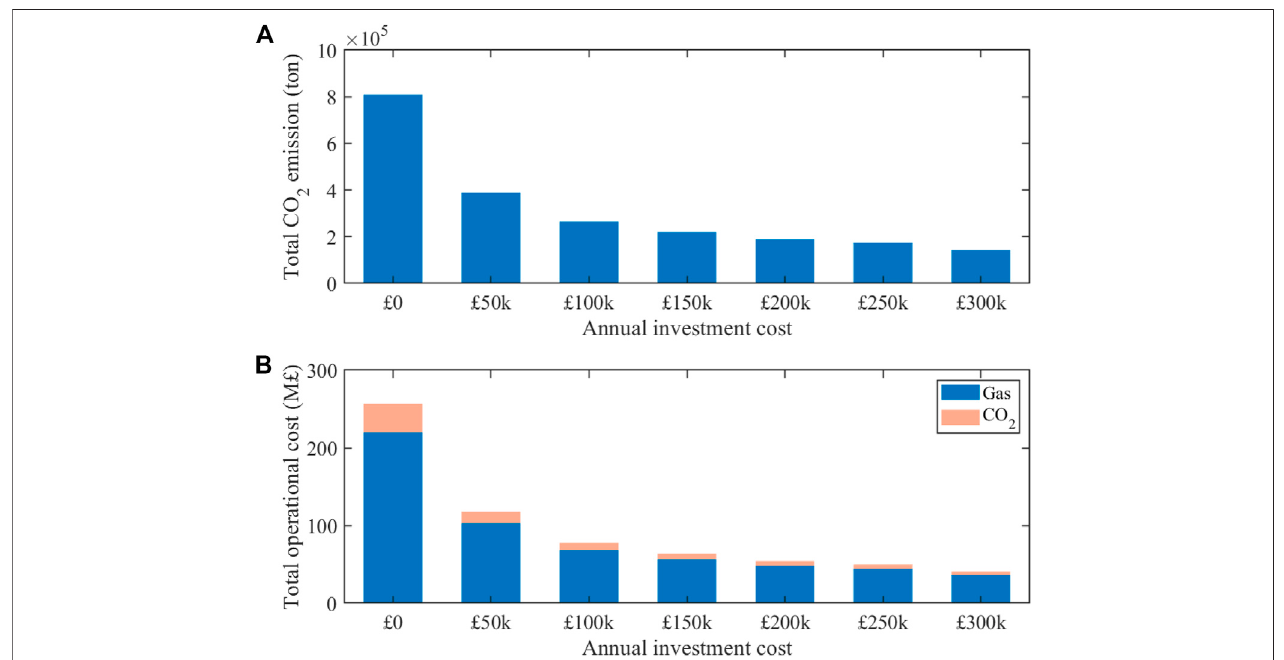
FIGURE 8 | Total CO 2 emission and total operational cost versus different annual investment cost until